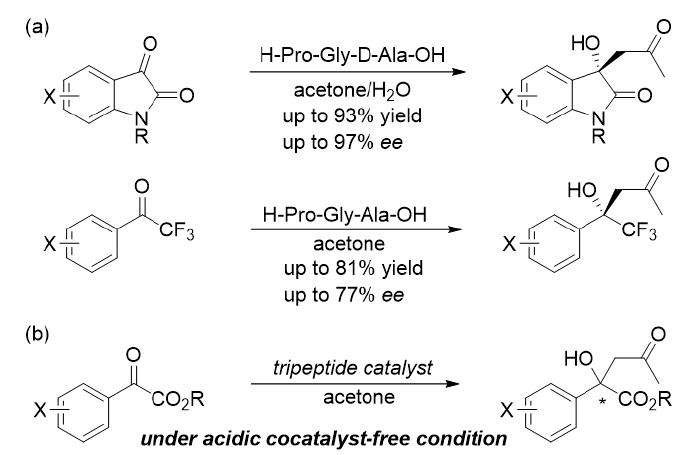
Figure 1. ( a ) Our previous works; ( b ) this work.